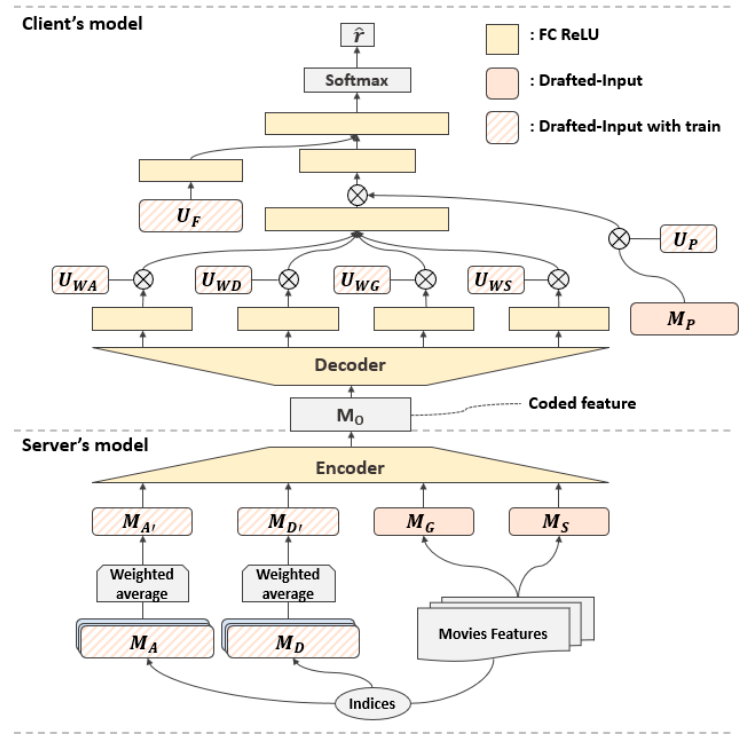
Figure 3. MovieDIRec+ model overview. Yellow boxes mean FC blocks, and red boxes mean Drafted-Input. Among the red boxes, the boxes drawn with an oblique line are Drafted-Inputs that are learning objects.